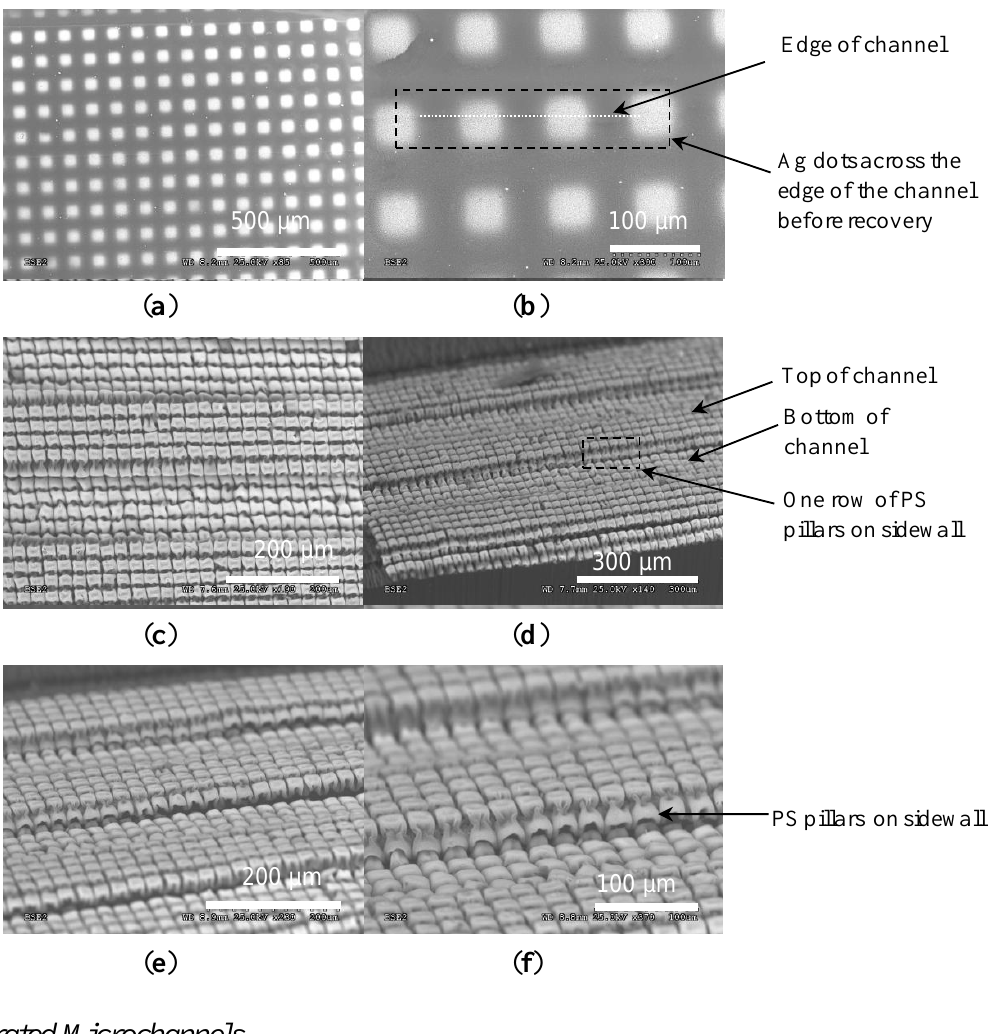
Figure 3. SEM images of 500-µm-wide channels with 50 × 50 µm 2 Ag dots. ( a , b ) Top view of Ag dots before recovery; ( c , d ) Top and side views of the sample after recovery; ( e , f ) Close-up views of the vertical sidewall with one row of polystyrene (PS)